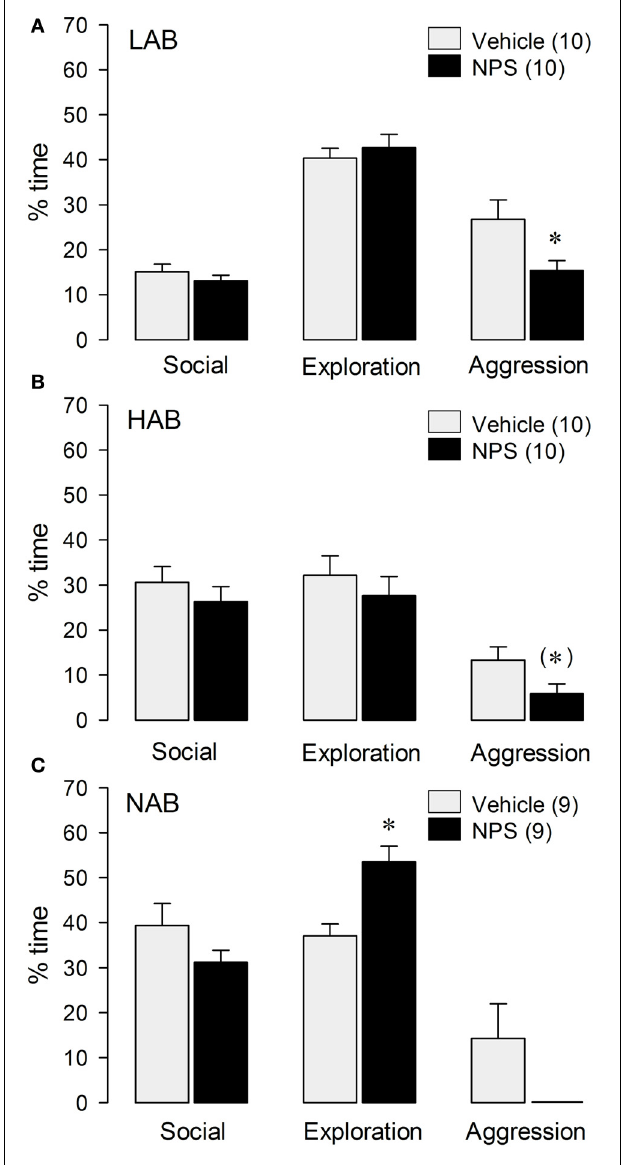
FIGURE 1 | Behavior of LAB (A), HAB (B), and NAB (C) rats during the RI test. NPS (1nmol) was applied icv 30min before testing. Social investigation, cage exploration, and aggressive behavior are calculated as percentage of total time (10min). Numbers in parentheses indicate group size. Date are means + s.e.m., ∗ p < 0 . 05 vs. vehicle, ( ∗ ) 0.1 > p > 0 . 05. Student’s t